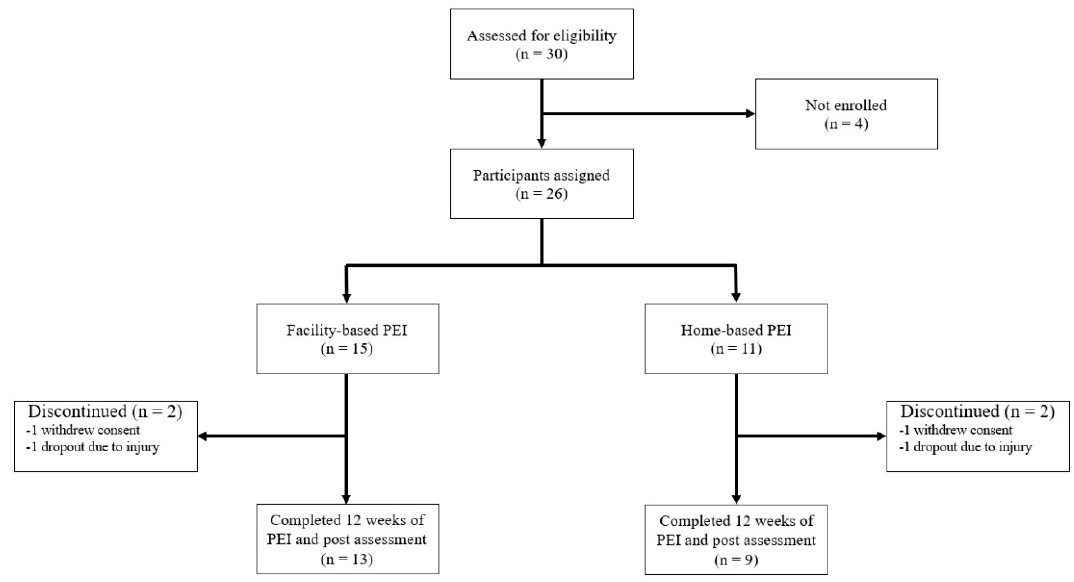
Figure 2. Trial profile. PEI, physical exercise intervention.